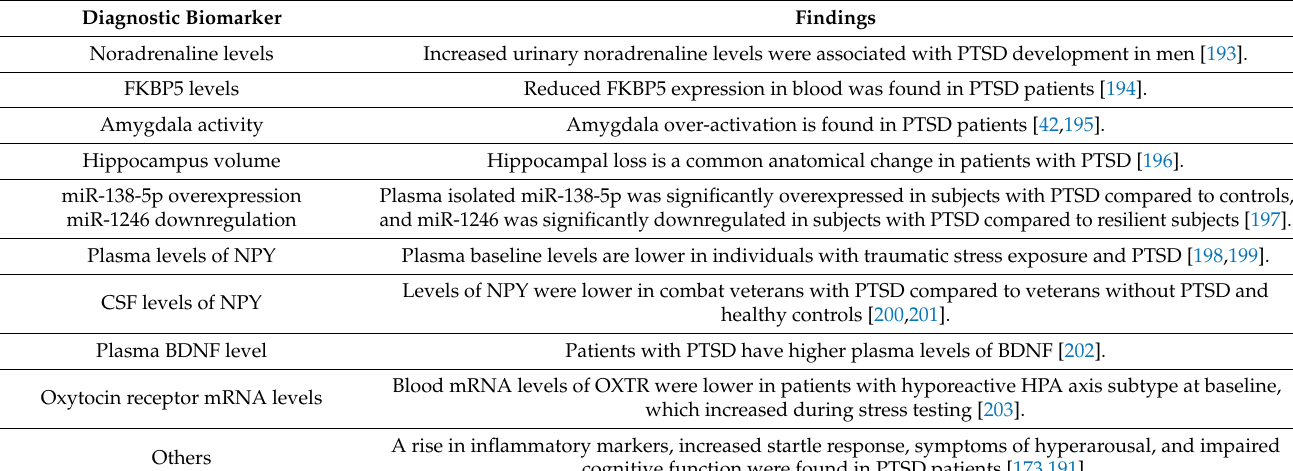
Table 3. Summary of the diagnostic biomarkers implicated in